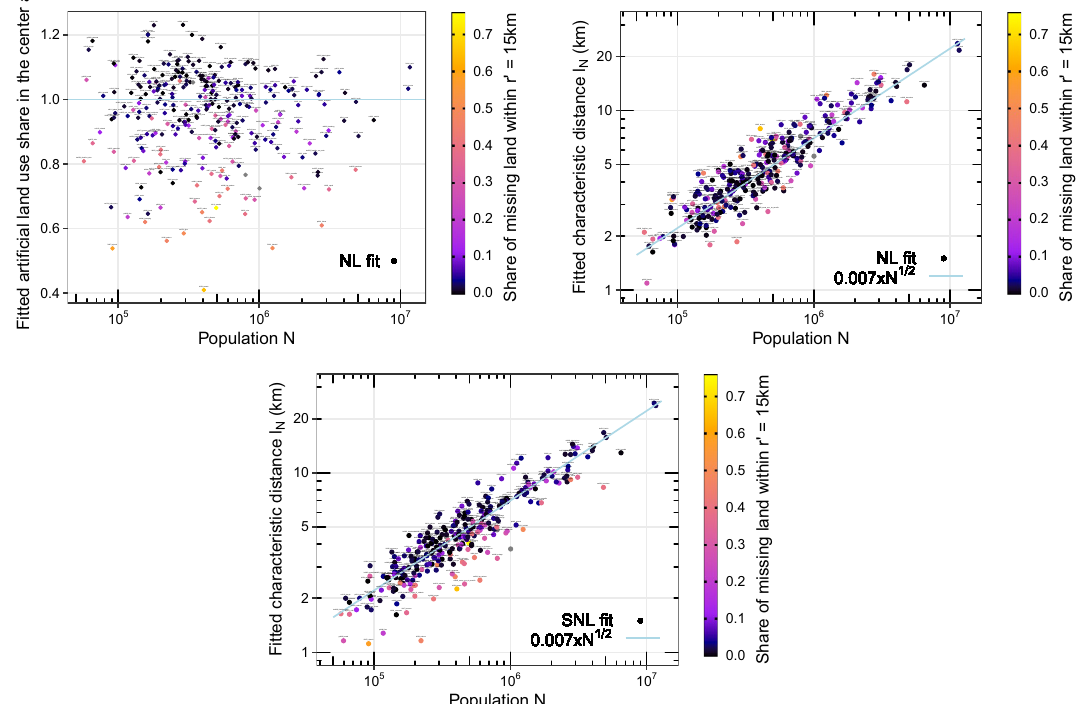
Figure 2. Estimated parameters of the exponential fits of artificial land use profiles, displayed as functions of the total population N . Predicted share a N of artificial land in the center (top left) and characteristic decrease distance l N (top right) with a two-parameter fit, and characteristic decrease distance l N with a one-parameter fit (bottom). The straight lines give expectations 4 : a N = 100 % on the top left (whatever the total population), and a N on the top right and scaling with the square root of total population √